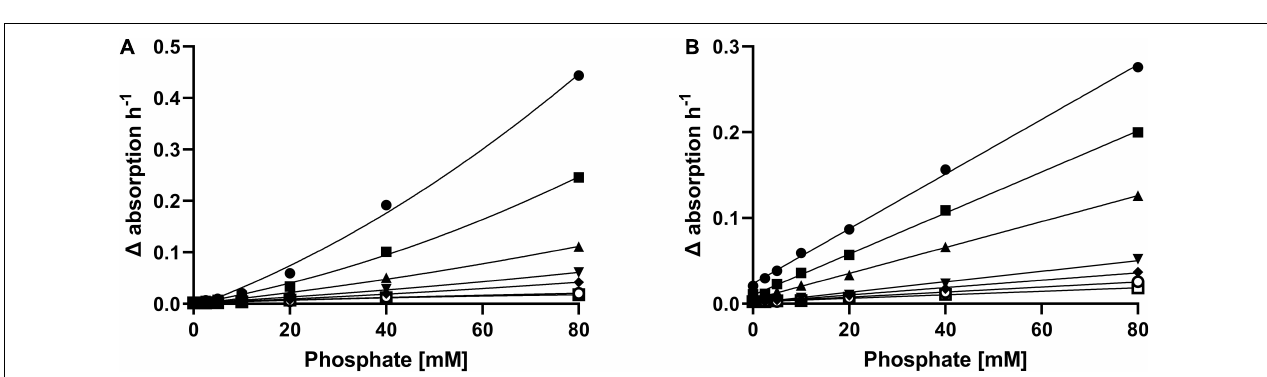
80 mM, (cid:4) (cid:32)